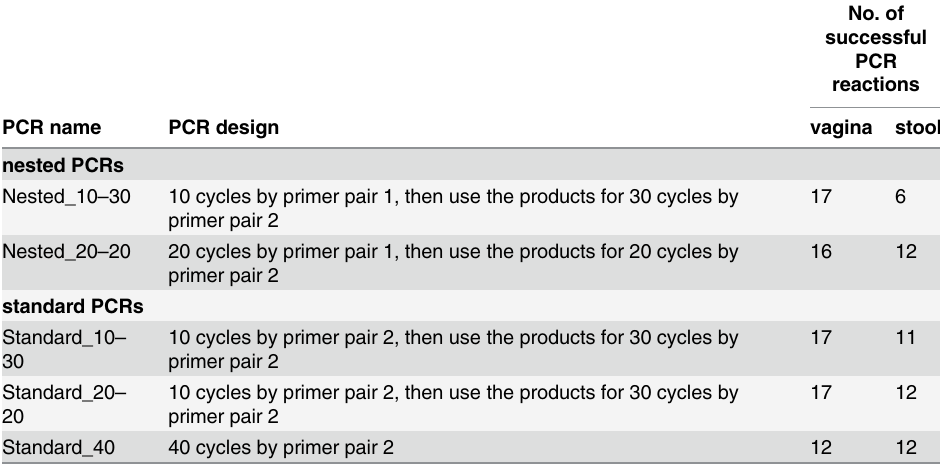
Table 1. The details for nested and standard PCR design and number of successful PCR reactions in vagina and stool samples.